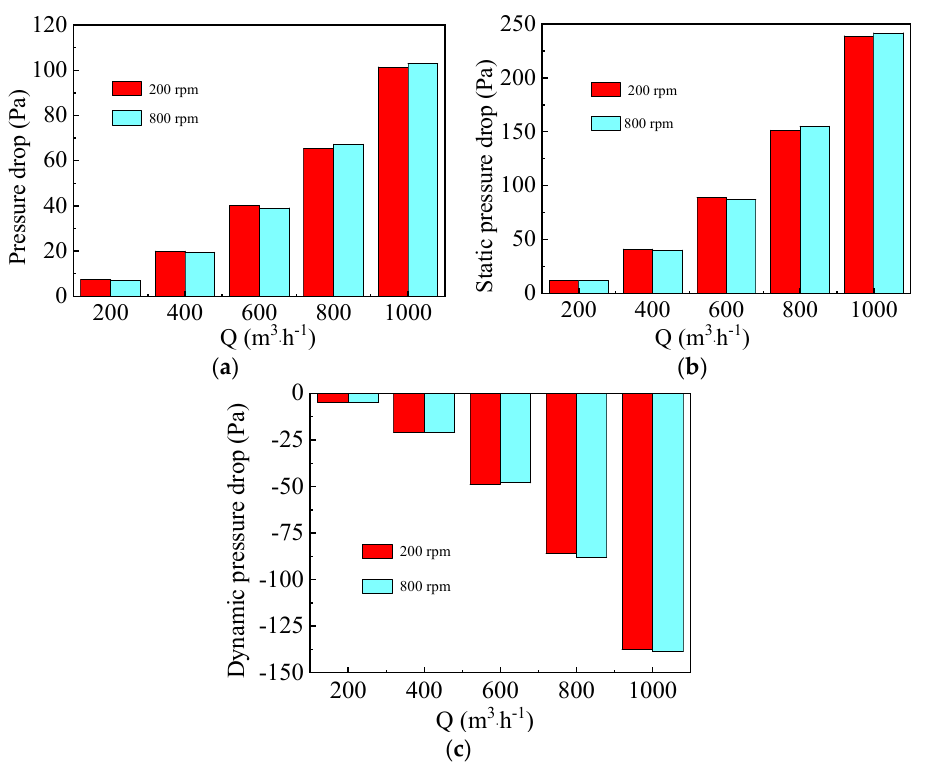
Figure 14. The effect of the gas flow rate on the pressure drop in the outlet zone. ( a ) Pressure drop; ( b ) static pressure drop; ( c ) dynamic pressure drop.